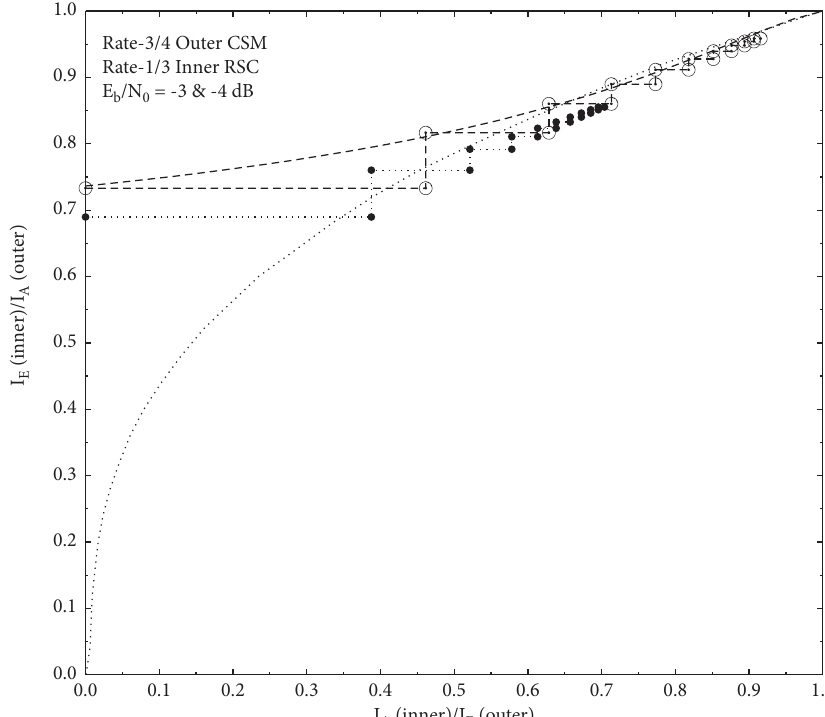
Rate-3/4 Outer CSM Rate-1/3 Inner RSC